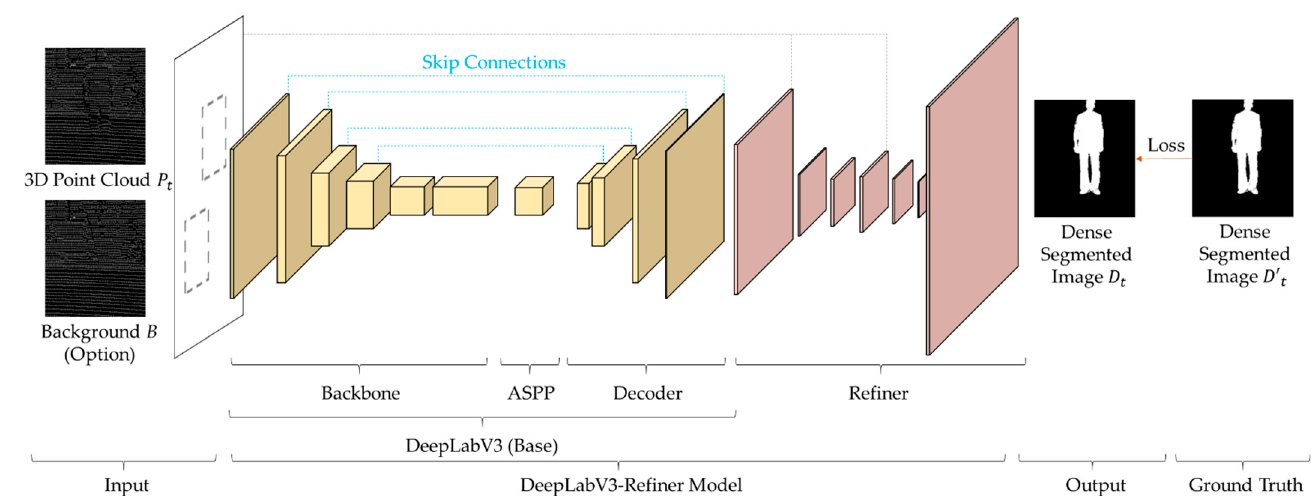
Figure 4. Proposed DeepLabV3-Refiner model architecture. The base model provides segmentation for a 3D point cloud and with roughly increased density. In the refiner model, the 3D point cloud with increased density in the base model is refined to fit the human object.